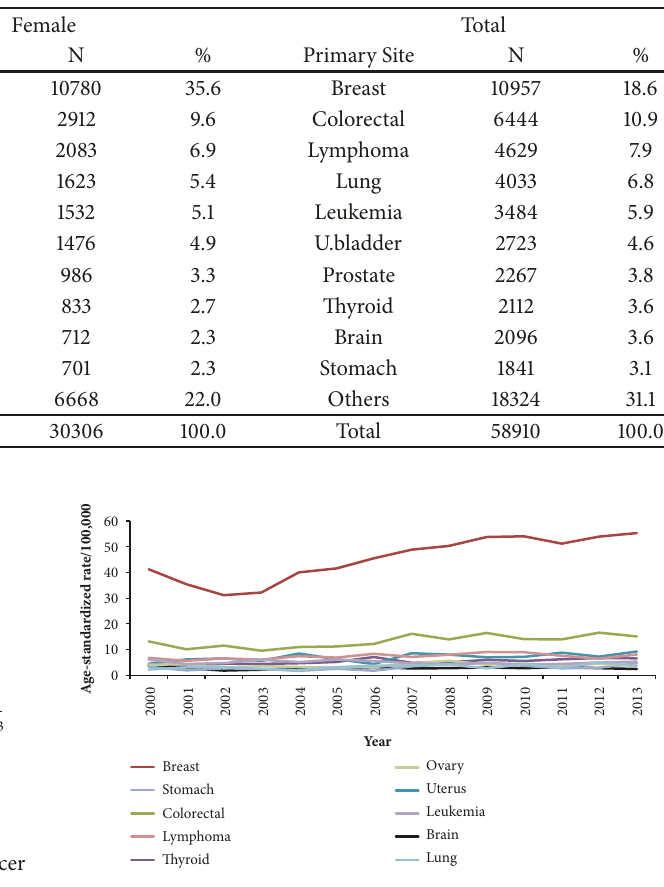
Figure 3: The trend in the age-standardized incidence rates of top 10 cancers for females in Jordan,